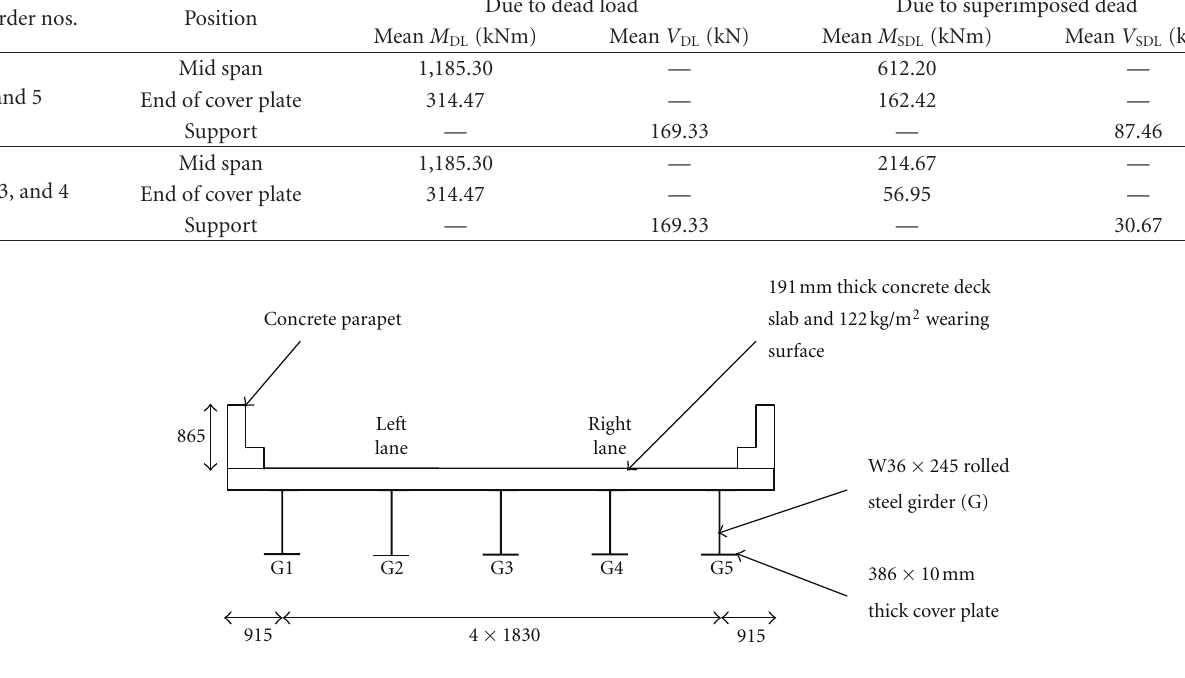
Figure 4: Typical cross section of two-lane rolled steel girder bridge (unit: